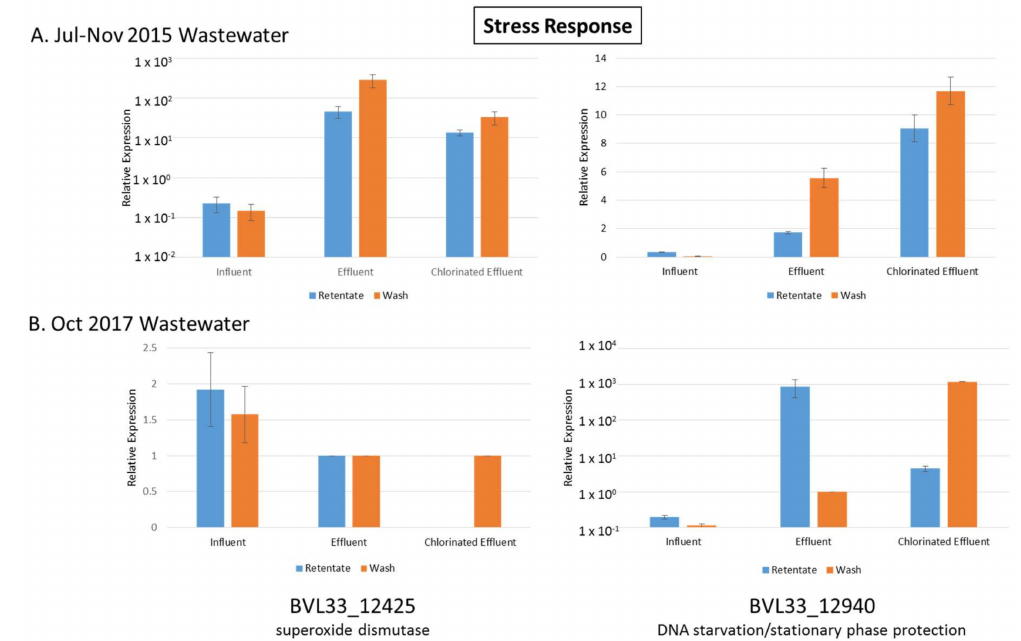
Figure 4. Relative expression profiles of A. junii genes involved in stress response. These genes displayed >2-fold change on RNA-seq analysis of wastewater sampled in July–November 2015 (Table 1). Gene expression values were normalized against a housekeeping rpoB gene. ( A ) Wastewater sampled in July, October and November of 2015; and ( B ) wastewater sampled in October 2017.